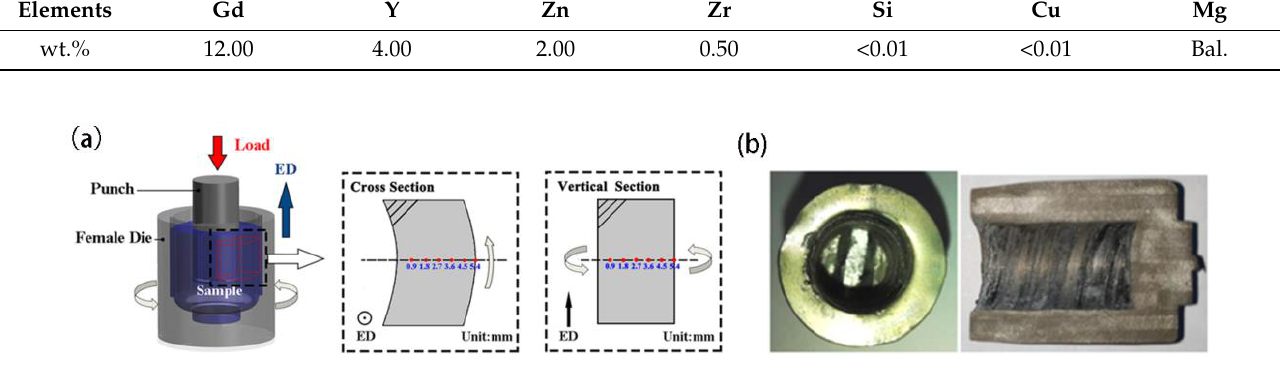
Figure 1. ( a ) The principle of the rotating backward extrusion (RBE) process, ( b ) the shape of the manufactured sample after the RBE process.